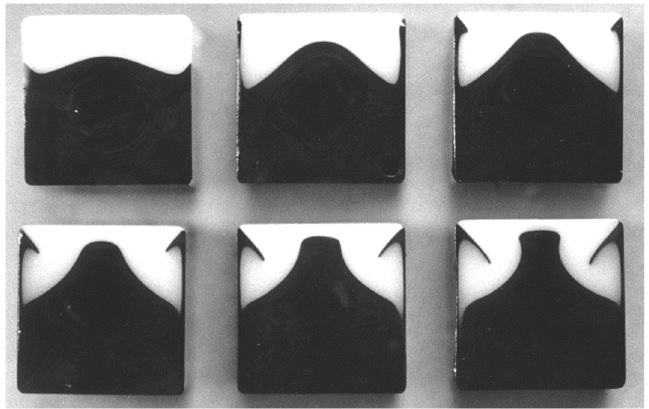
Figure 28. Encapsulation phenomenon observed in the coextrusion flow of two layers of the same Polystyrene with different colors (Reprinted from Refs. [11,45]).